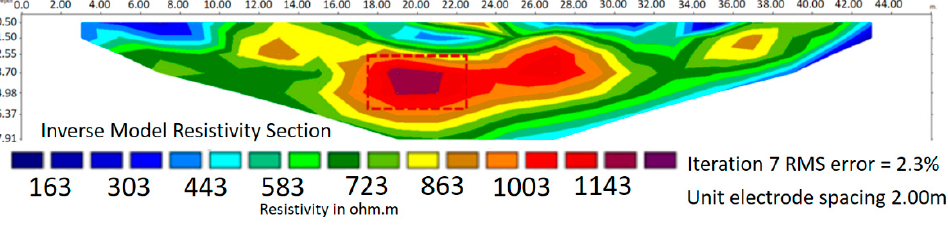
Figure 4. L2 Figure 4. L2 result. Figure 4. L2 result.